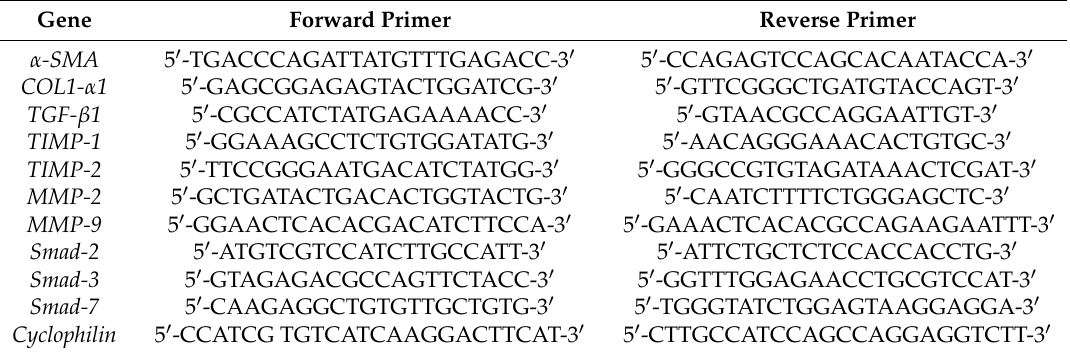
Table 5. Primer sequences for Polymerase Chain Reaction (PCR) analysis in this